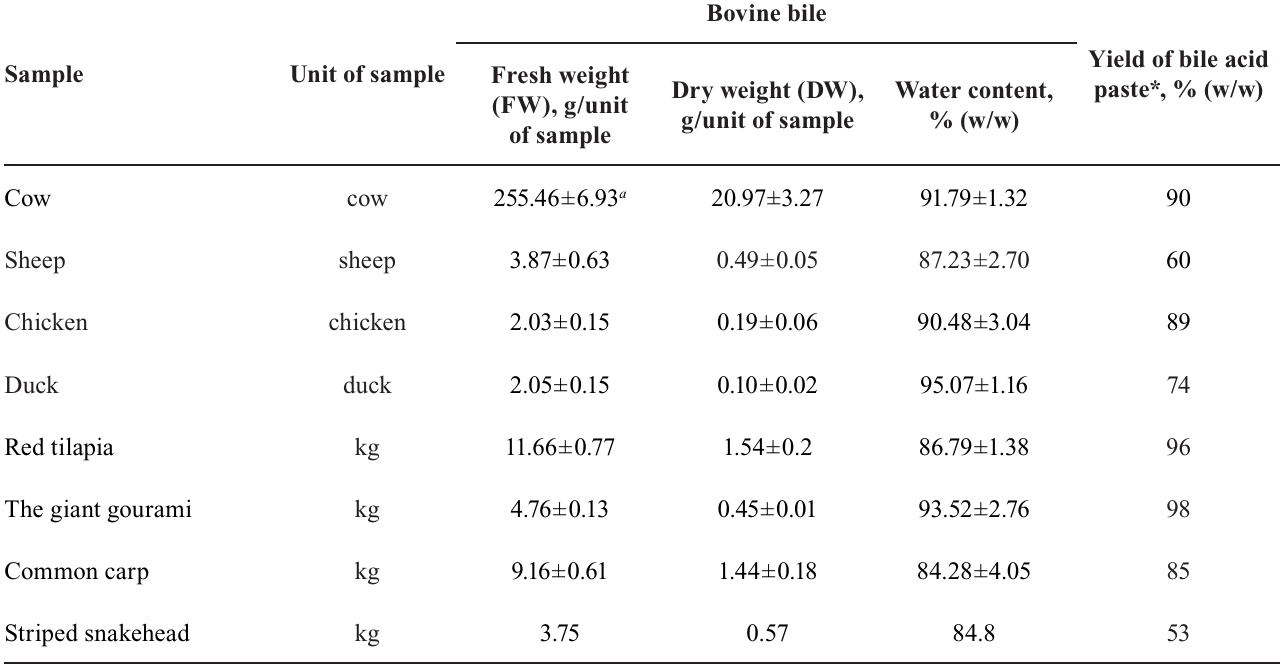
TABLE I - A nimal samples and their biliary bile contents